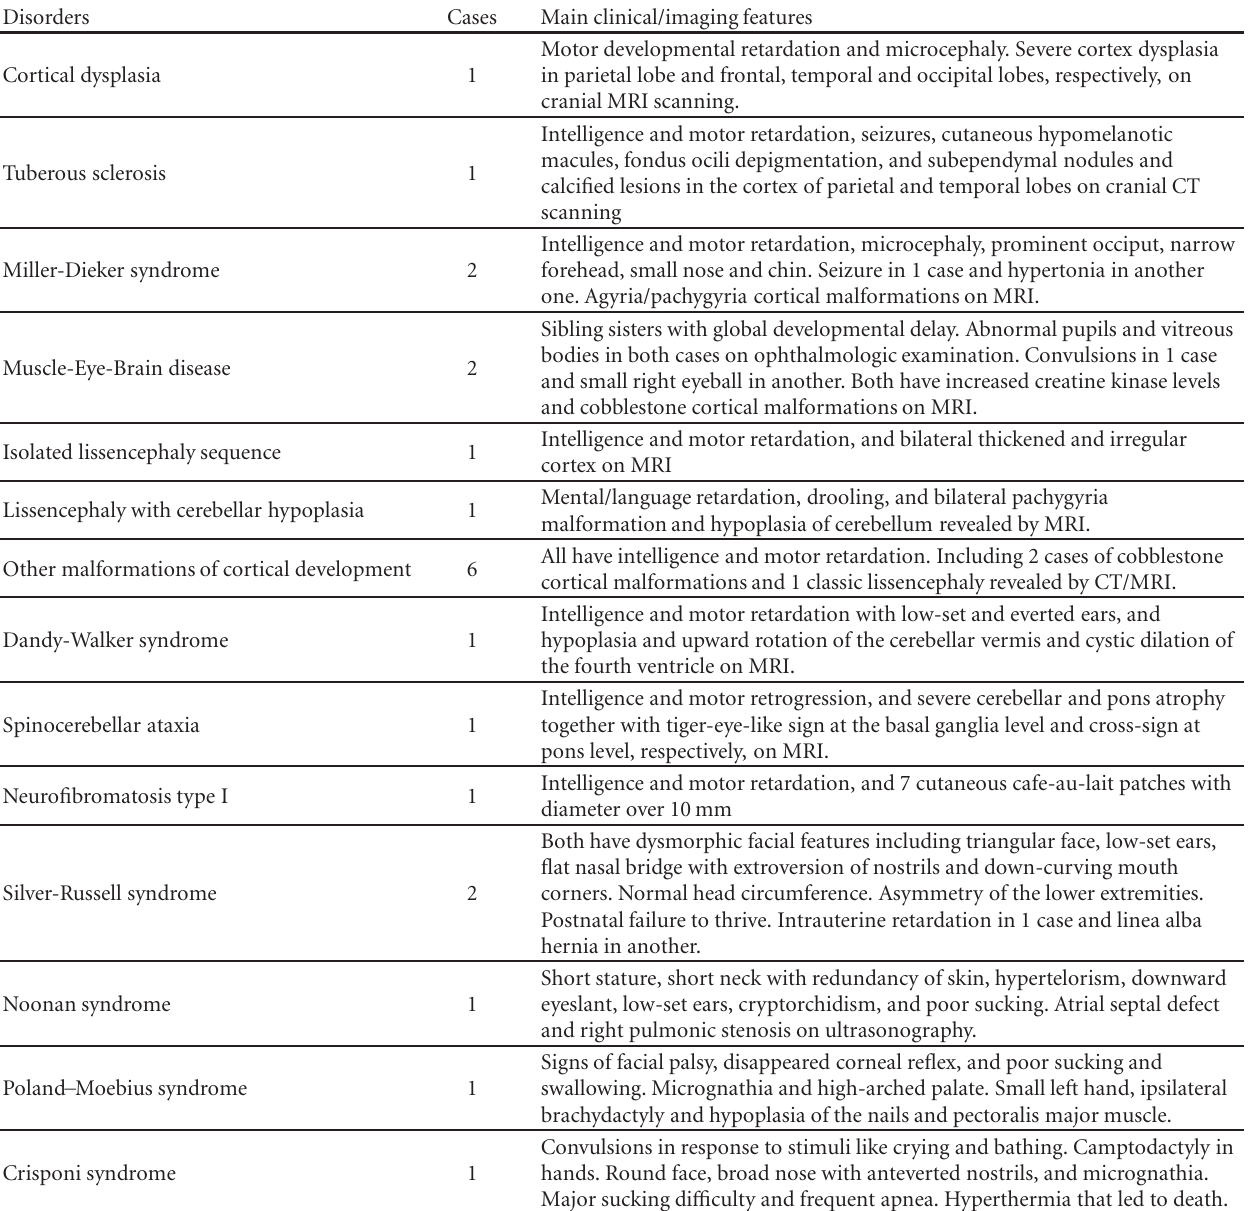
Table 5: Congenital dysmorphic disorders in the patients with genetic diseases in Table